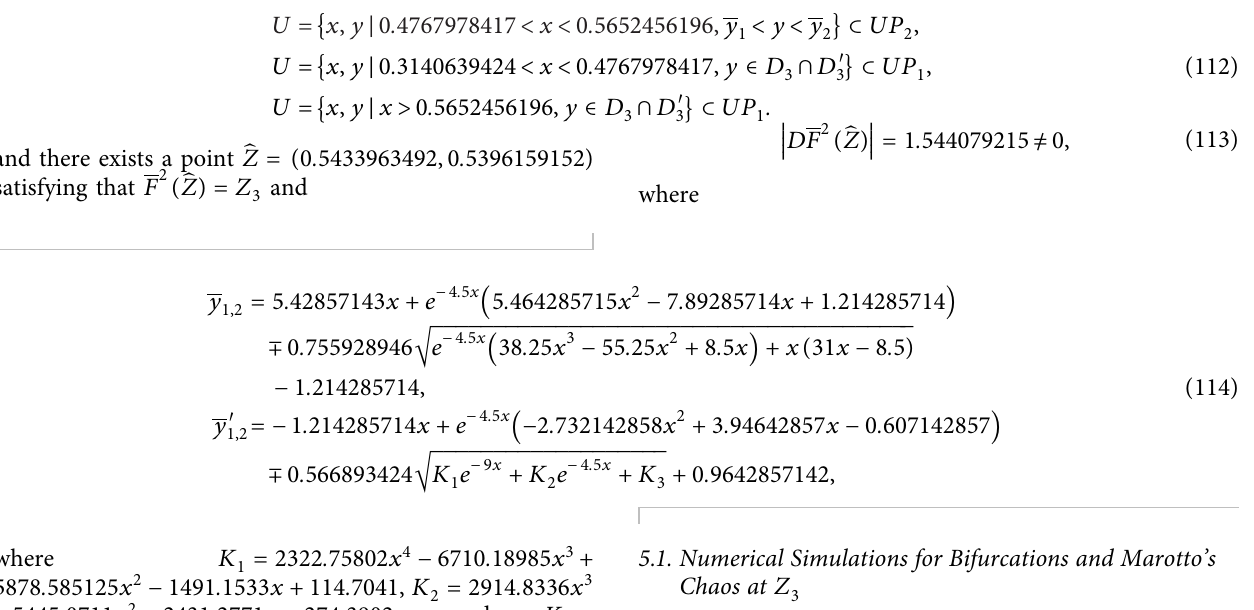
with a � 2 . 1 , r � 2 . 55, and ε � 4 . 3